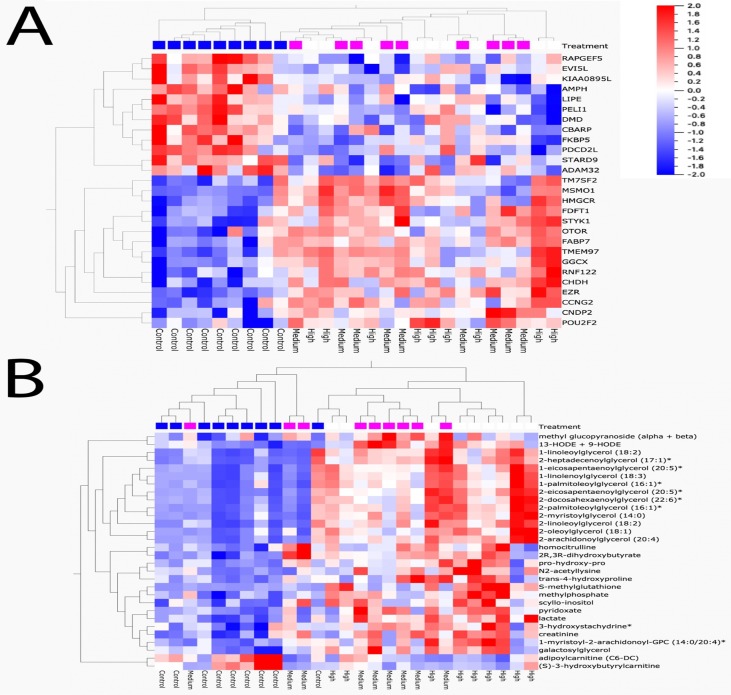
Heat map of transcripts and metabolites that best discriminate between control and chlorpyrifos-methyl-treated groups (medium + high combination). (A) Transcripts and (B) metabolites. FDR < 0.1